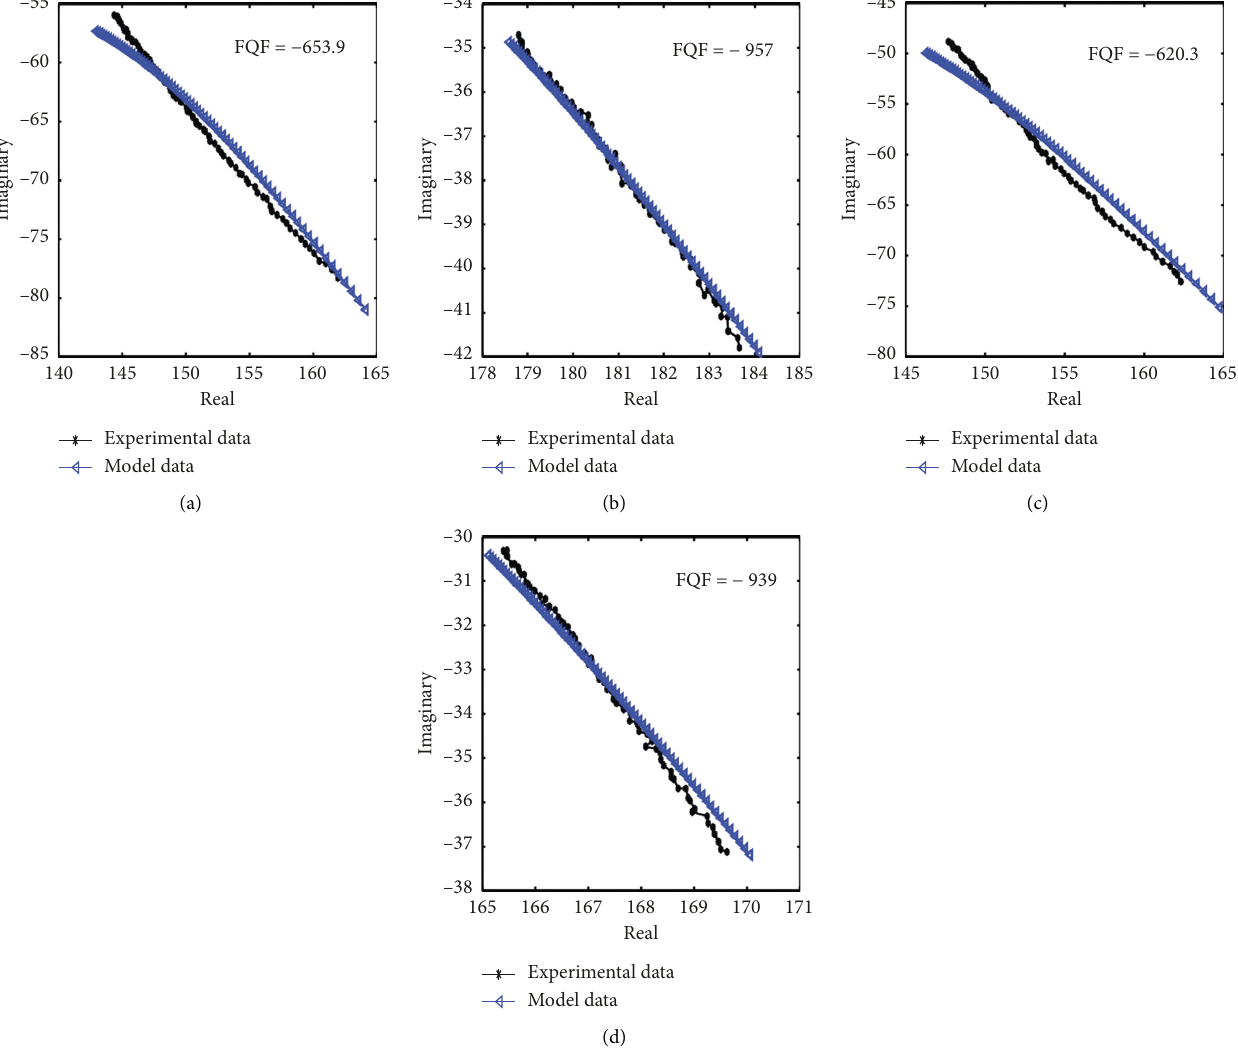
Figure 2: Detection of chemicals in milk. (a) FOE13 in pure milk; (b) FOE8 in pure milk; (c) FOE13 in 0.6 mg/ml urea adulteration; (d) FOE8 in 0.6 mg/ml urea